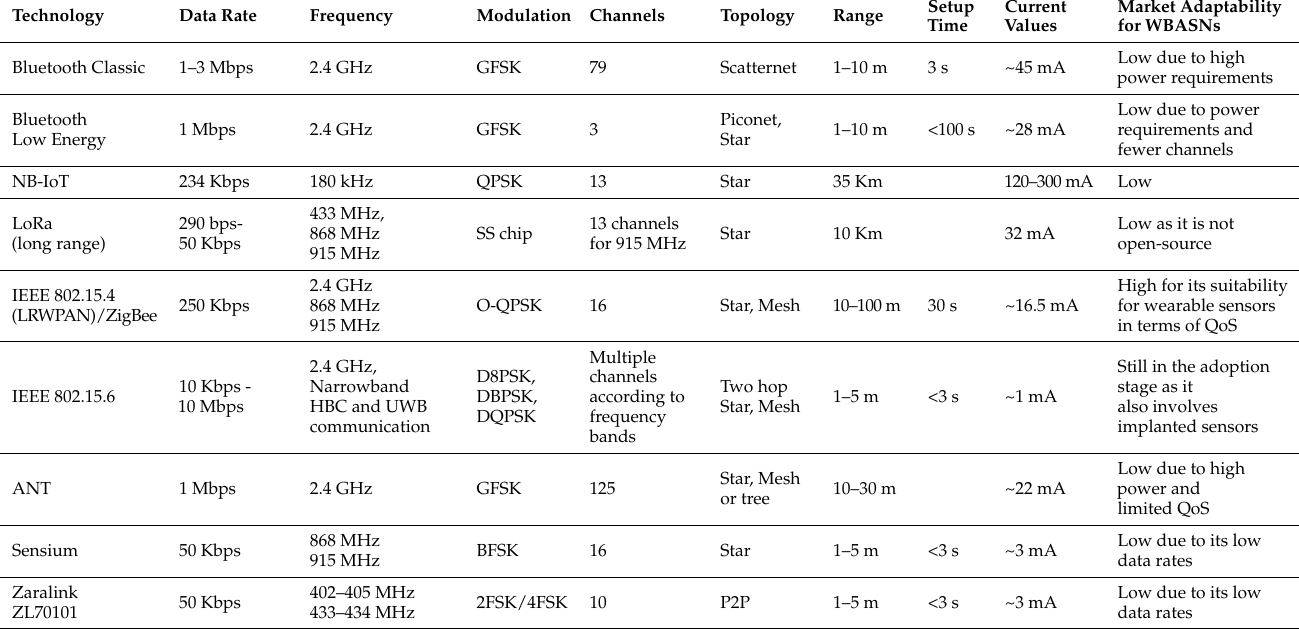
Table 5. Characteristics and comparison of available technologies [67].